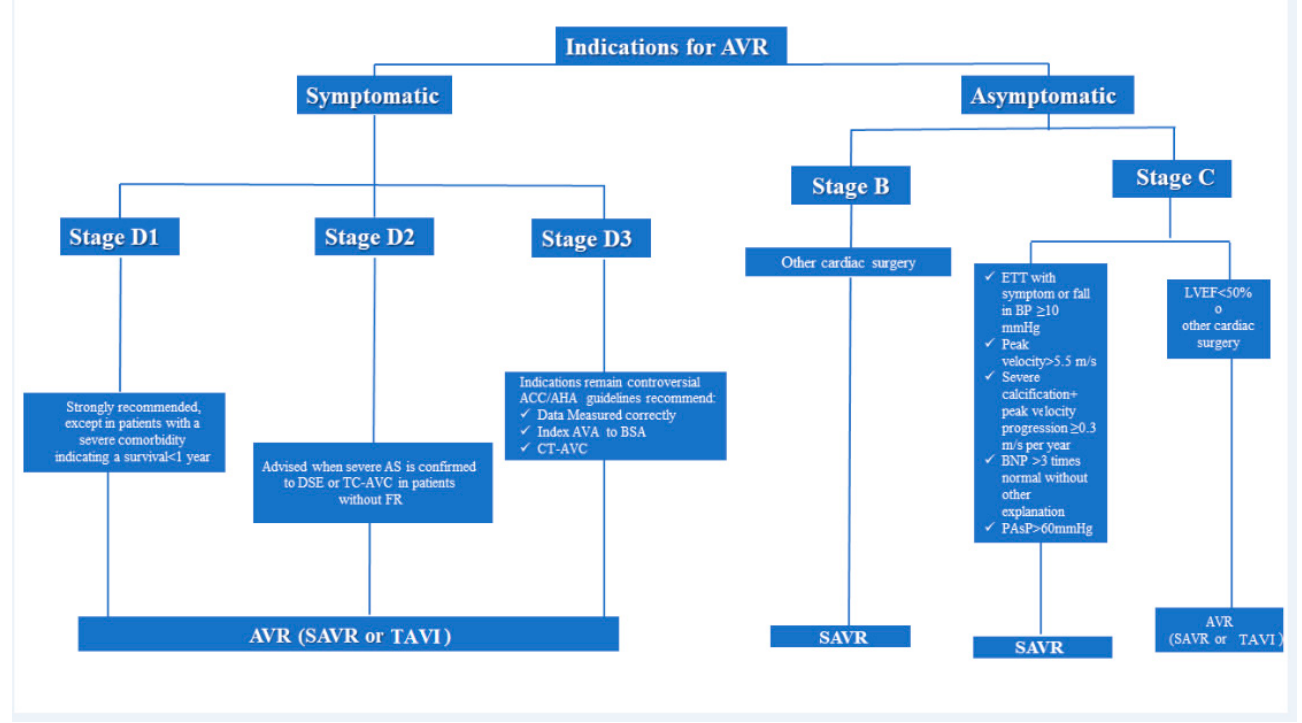
Figure 6. Current recommendation from European and American guidelines for aortic valve replacement in aortic stenosis. AVR: Aortic Valve Replacement. AS: Aortic Stenosis. DSE: Dobutamine Stress Echocardiography. SAVR: Surgical aortic valve replacement. TAVI: Transcatheter aortic valve replacement. ACC/AHA: American College of Cardiology/American Heart Association. AVA: Aortic valve area. BSA: Body Surface Area. TC-AVC: computed tomography aortic valve calcium scoring. LVEF: left ventricular ejection fraction. PAsP: Pulmonary artery systolic pressure. ETT: exercise treadmill test BP: blood pressure.